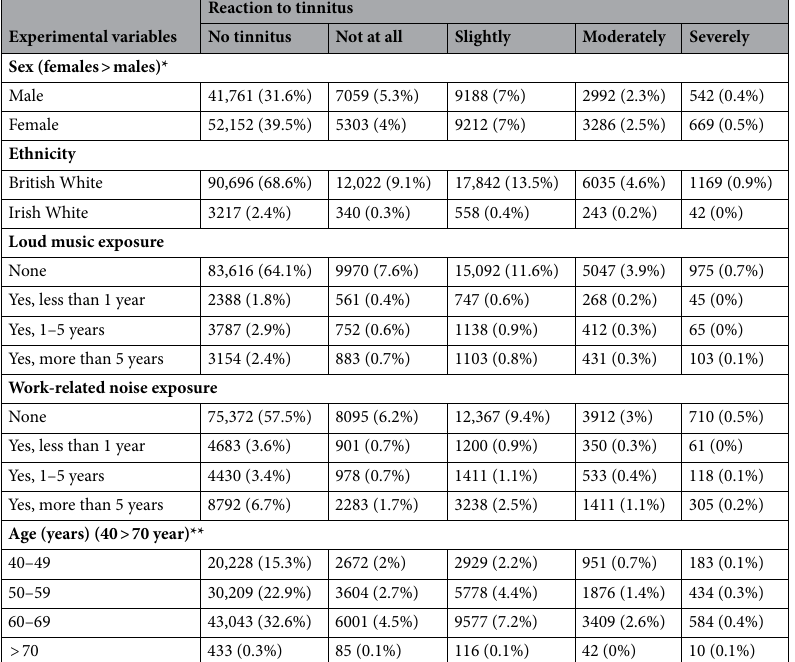
Table 2. Prevalence of reaction to tinnitus across the experimental variables. **Chi square p < 10 –88 , *Chi square p < 10 –10